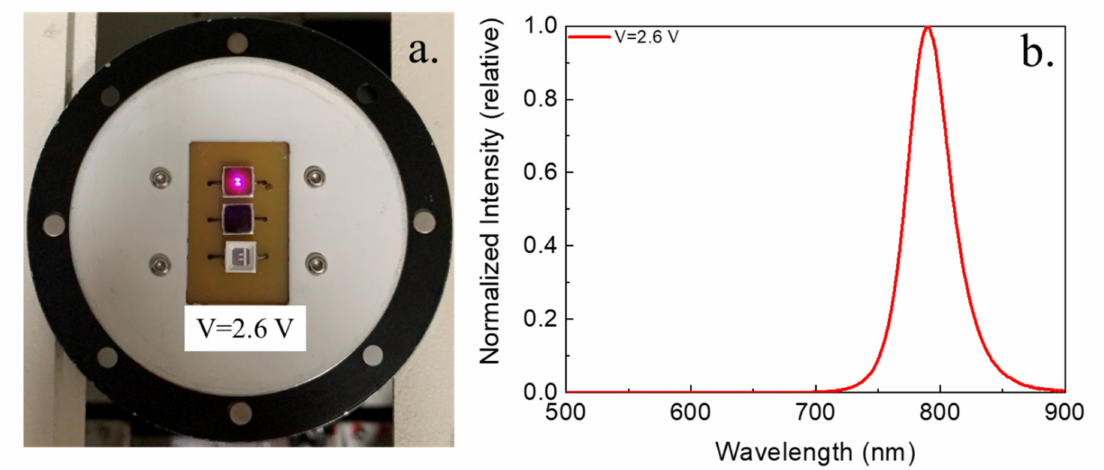
Figure 7. The photographs of the blue chip (455 nm) and the blue chip consisting of FAPbI 3 NCs under the ( a ) room light and ( b ) the NIR-LED devices EL